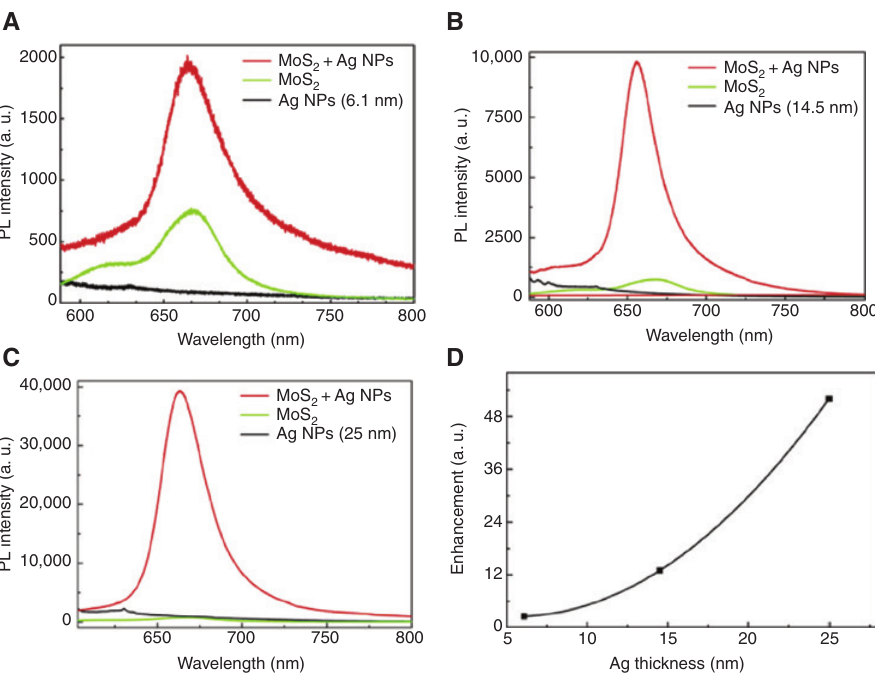
Figure 13: Schematics of the relation between the fluorescence intensity and the diameter of gold nanoparticles. (A–C) LSPR on the surface of different diameter metal particles, and different fluorescence enhancement results can be obtained, where the diameters of AgNPs are 6, 14, and 25 nm, respectively. (D) Enhancement factors for different thicknesses [186].